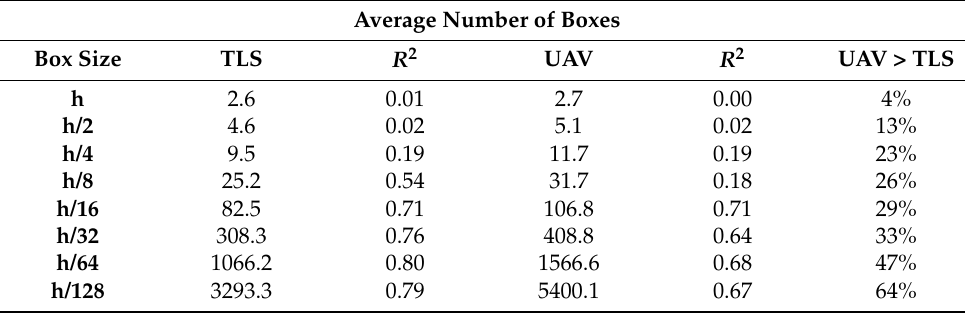
Table 12. The average number of different box sizes required by terrestrial laser scanning (TLS) and unmanned aerial vehicle (UAV), h = tree height measured with either TLS or UAV, and h/ n = tree height divided by n. The coefficient of determination ( R 2 ) explains how much the number of boxes affects the box dimension (D b ) values; UAV > TLS shows how much more boxes UAV used than